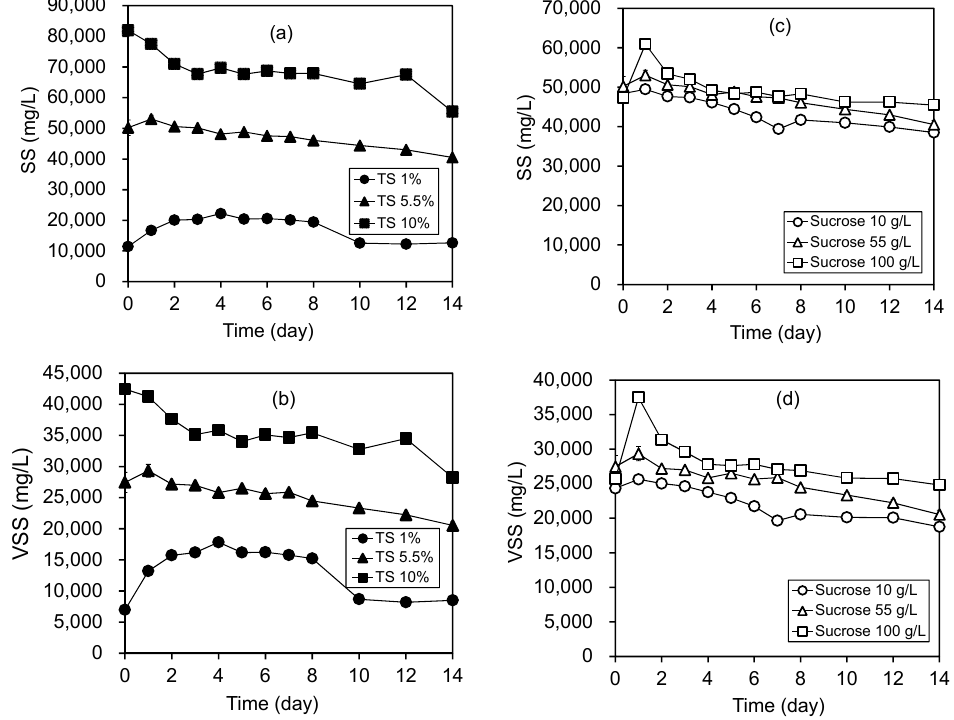
Figure 6. Degradation of solids during the fungal bioleaching experiments ( a , b ) effects of sludge solid content, ( c , d ) effects of sucrose concentration.